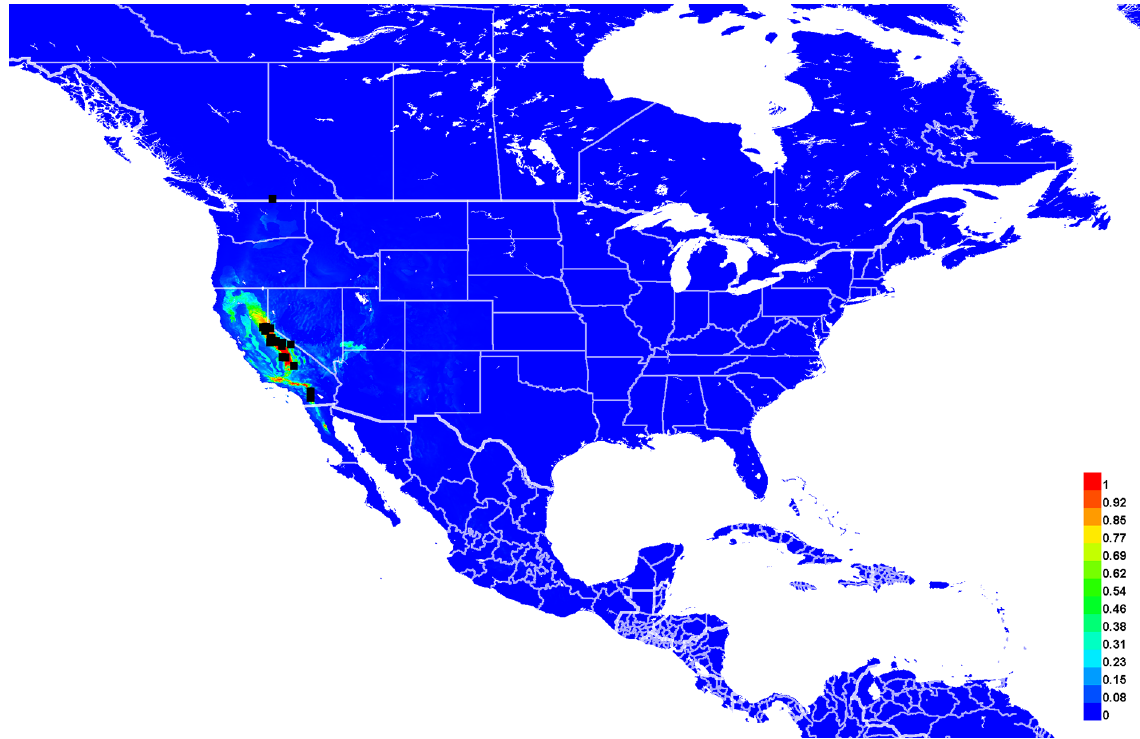
Fig. 87. Georeferenced collection records of Lasioglossum ( D. ) tuolumnense Gibbs, 2009 (black squares) and predicted distribution by maximum entropy ecological niche modeling in Maxent (colour shading). Warmer colours indicate higher cloglog probability of occurrence. Note that L. ( D. ) tuolumnense is also believed to occur in Oregon based on a photographed